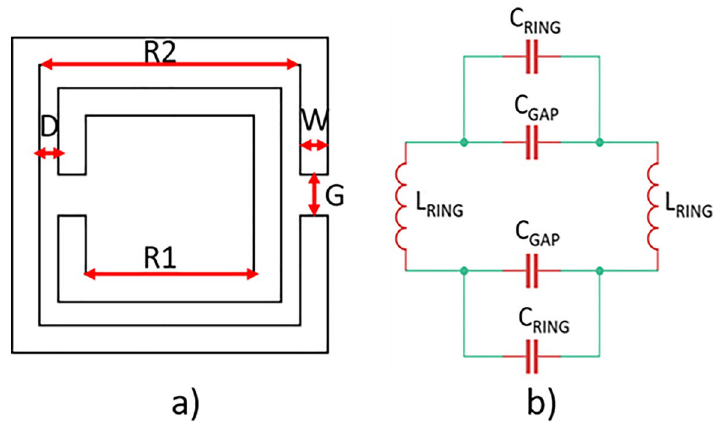
Figure 3. ( a ) Geometry and ( b ) equivalent circuit, of the